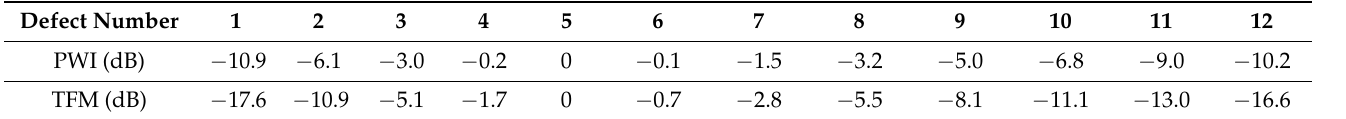
Figure 8. The projection of the maximum amplitude along the ( a ) x direction. The ( b ) z direction in the experiment. Table 3. Attenuation introduced at each defect in the experiment.